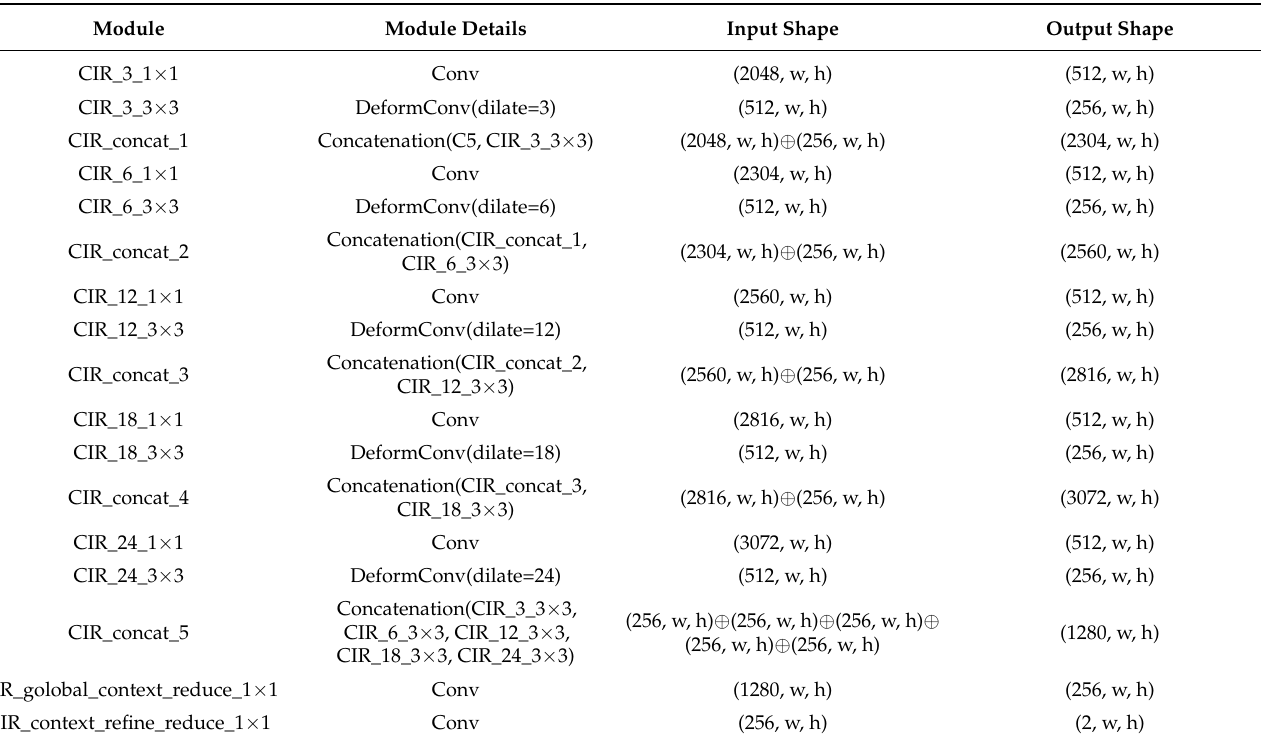
Table 1. Network architecture of the CIR